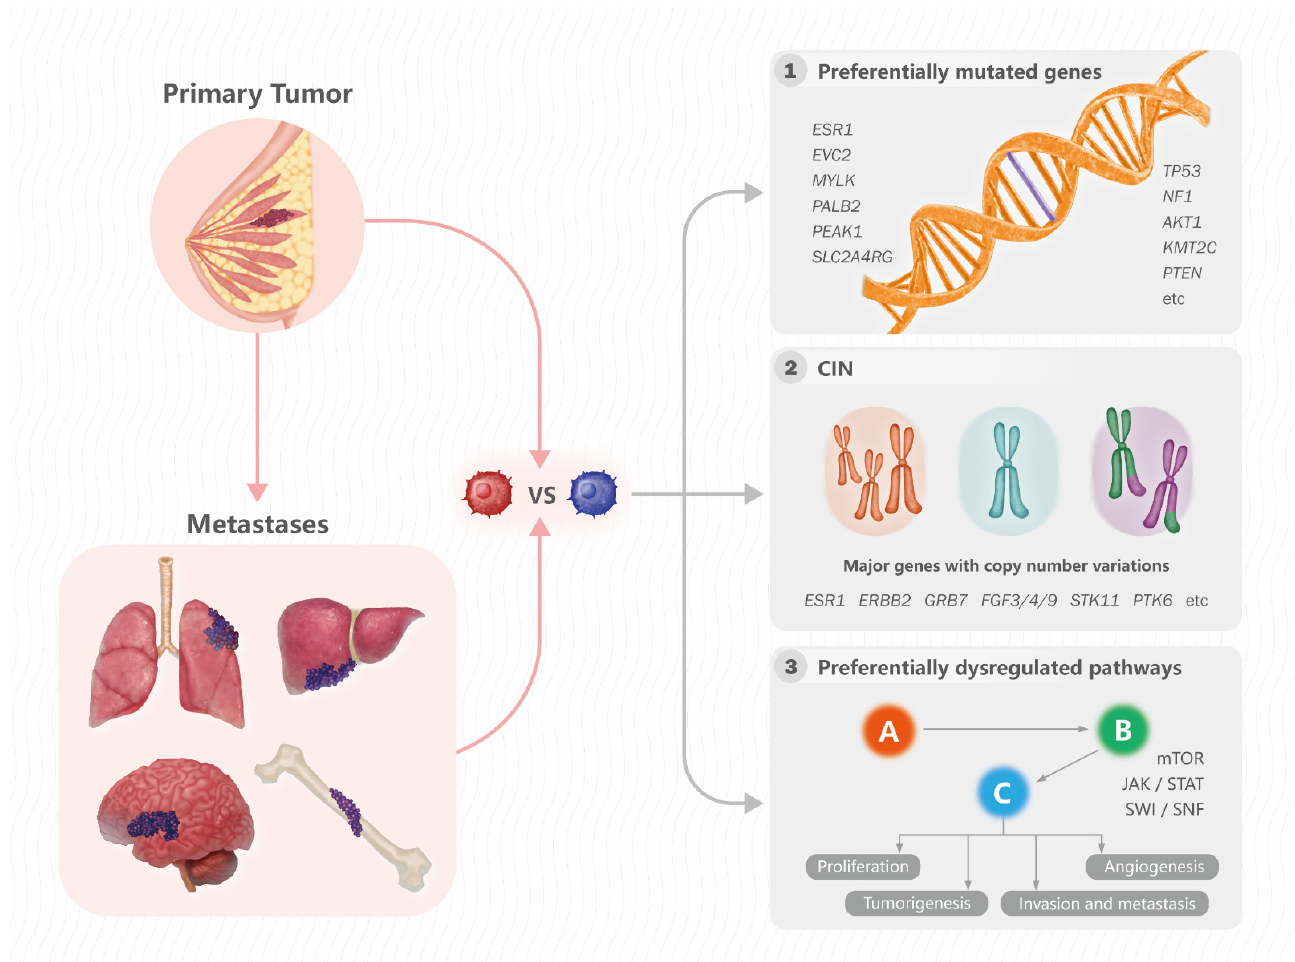
Figure 2. Major differences between primary and metastatic lesions . Major differences between pri- mary and metastatic lesions in somatic mutations, chromosomal instability and molecular path- ways. Major genes with copy number variations are also